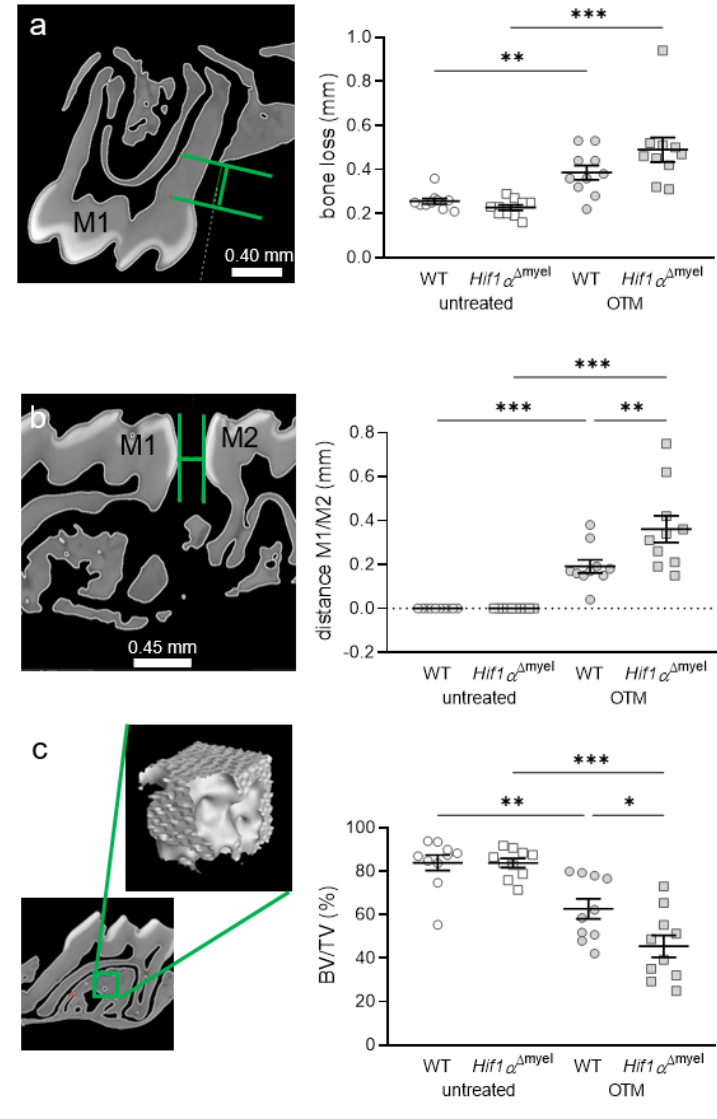
Figure 4. Periodontal bone loss ( a ) and orthodontic tooth movement ( b ) as the distance between the first (M1) and second (M2) molars, as well as bone density ( c ), at the orthodontically treated (OTM) and the untreated control jaw side in wildtype mice (WT) and mice without HIF1α in myeloid cells ( Hif1α Δmyel ). Statistics: ANOVA with uncorrected Fisher’s LSD post-hoc tests ( b ) or Welch-corrected ANOVA with unpaired t tests (a,c). n = 10; * p < 0.05; ** p < 0.01; *** p < 0.001.